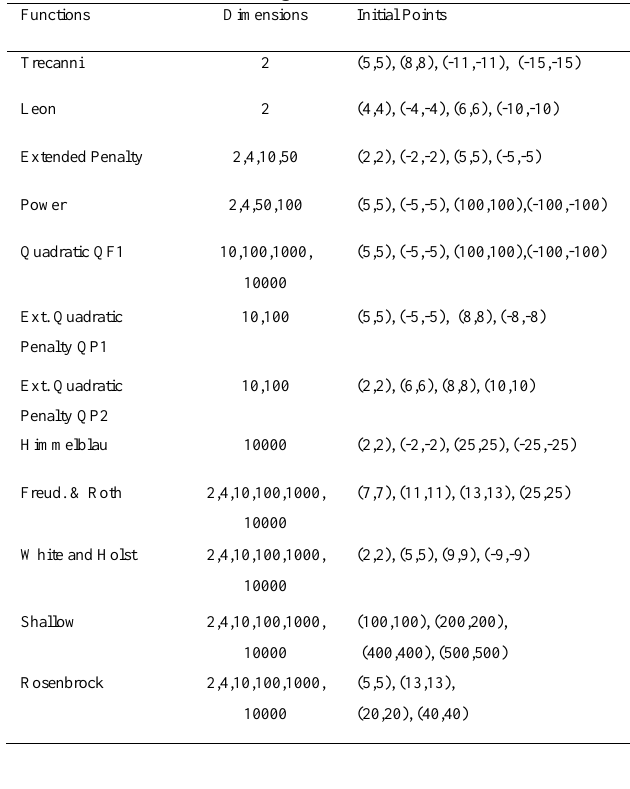
Table 5. Standard Test Problems functions for Figure 2 and Figure 3